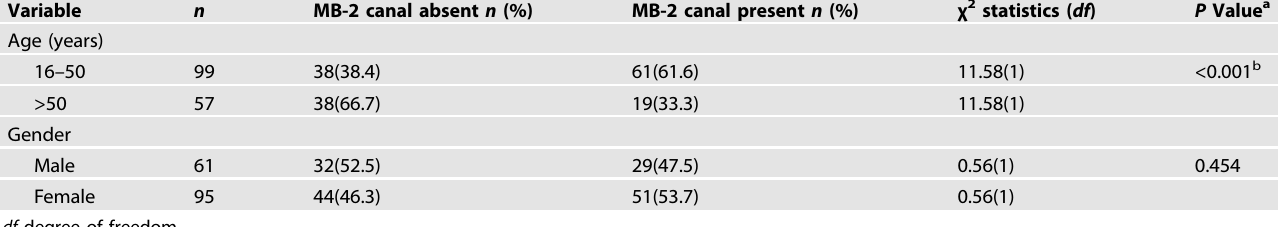
Table 2. Association of the presence of MB-2 canals in maxillary fi rst molars by gender, and age groups ( n = 156). Variable n Age (years)